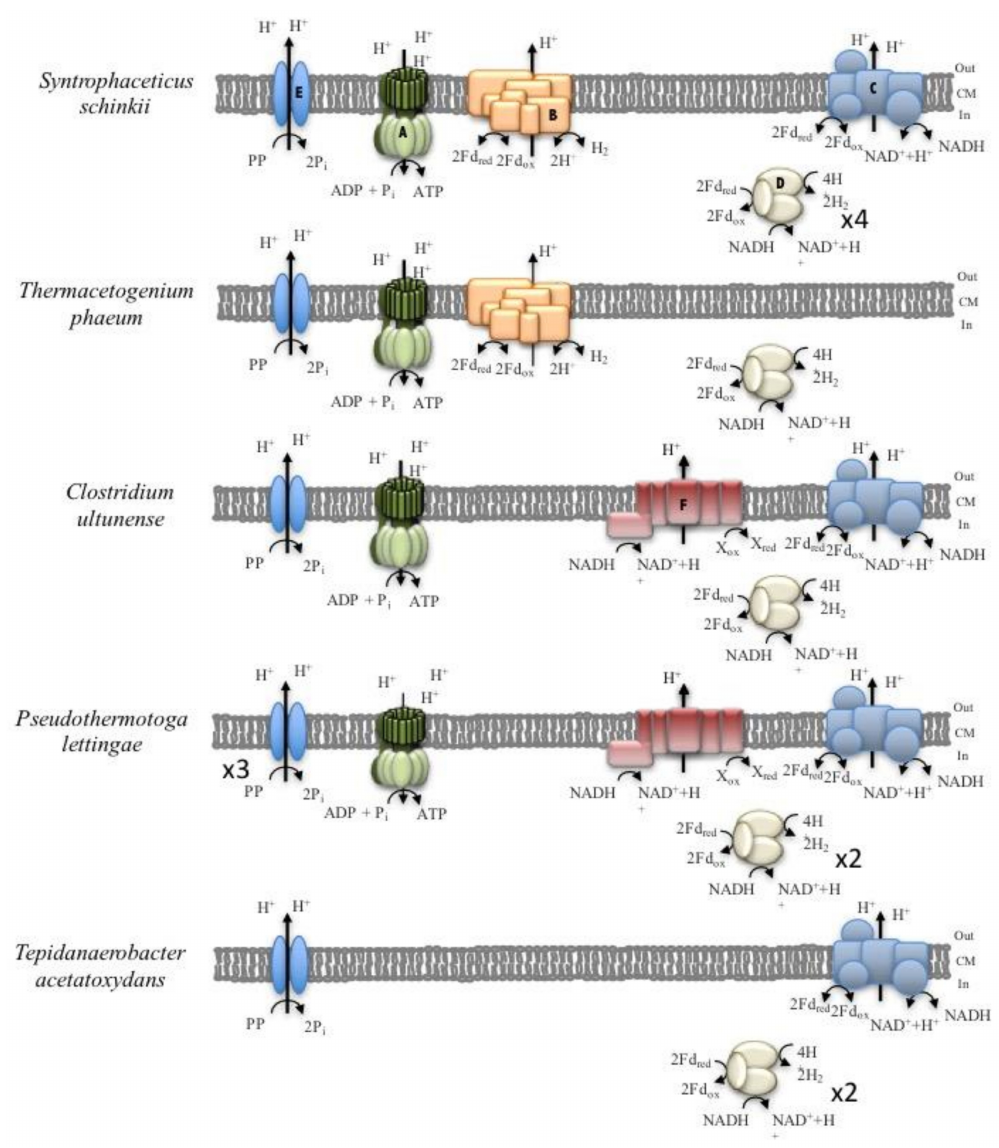
Figure 6. Energy conservation systems potentially involved in syntrophic acetate oxidation. (A) F 0 /F 1 ATP synthase, (B) Ech (energy-converting hydrogenase) hydrogenase, (C) Proton-translocating ferredoxin:NAD + oxidoreductase (Rnf) complex, (D) [Fe-Fe] hydrogenases, (E) ion-translocating pyrophosphatase, (F) NADH:quinone hydrogenase (NQR) complex. Numbers indicate predicted gene duplications. Na + translocation might occur instead of H +